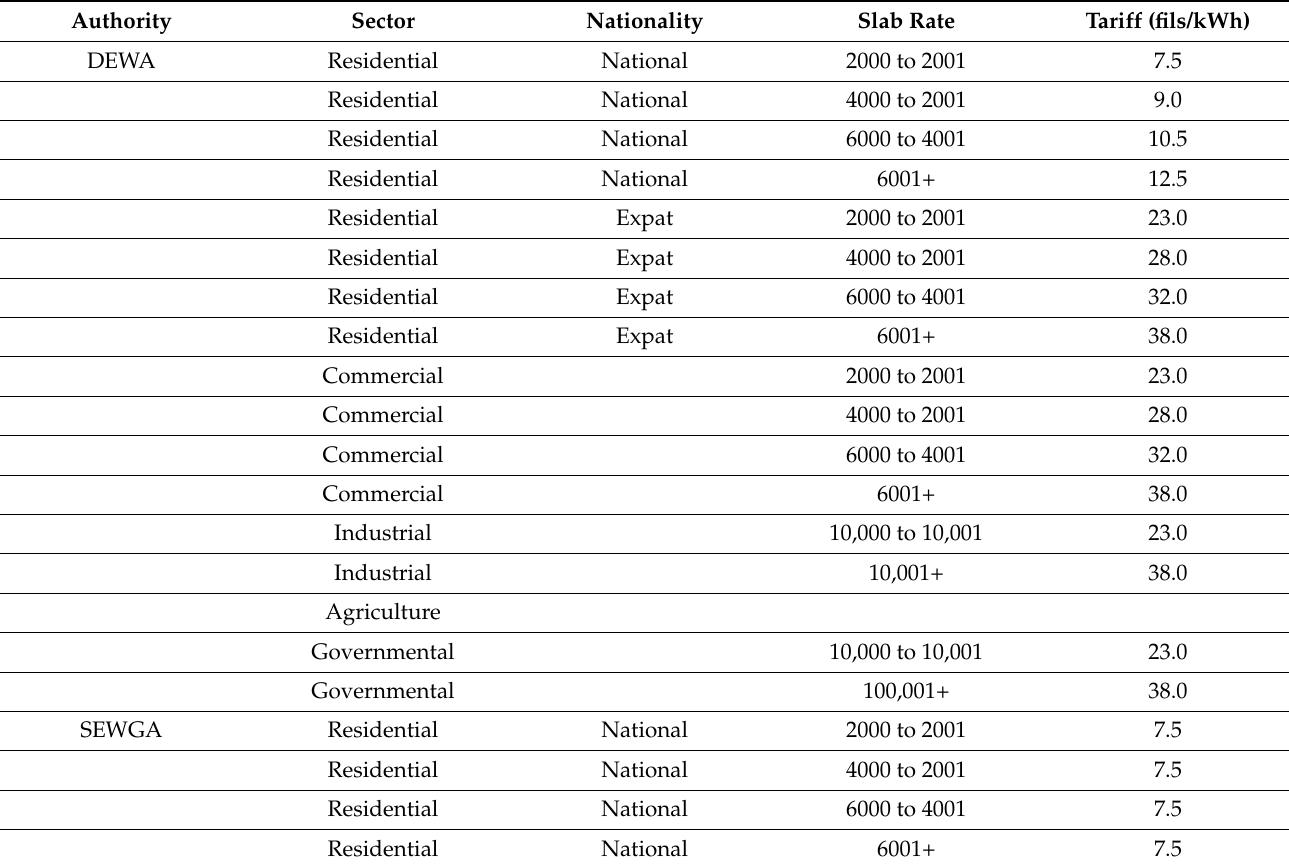
Table 2. Electricity tariffs of DEWA, SEWGA, and EWE authorities’ slab rate sector in 2016